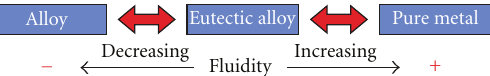
Figure 3: Fluidity dependency of metals based on composition.